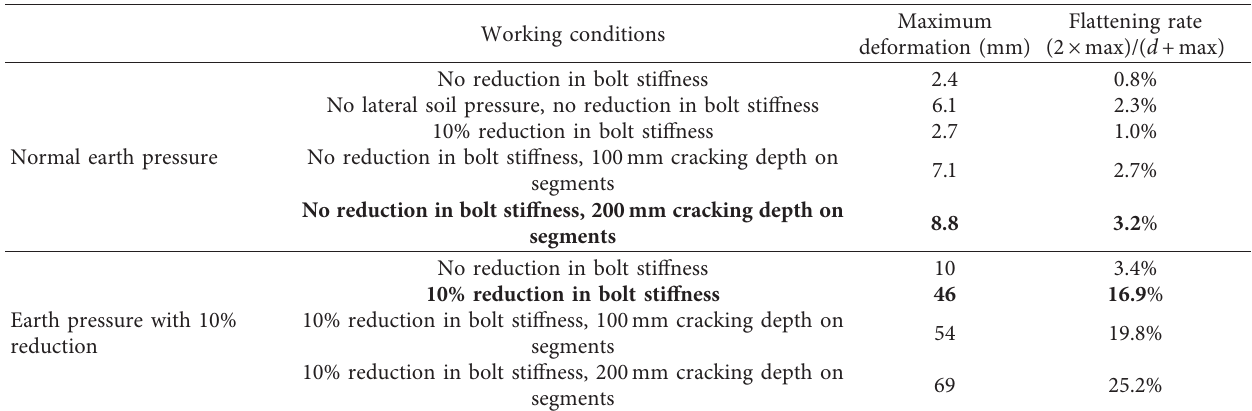
Figure 22: Staggered assembly of Table 3: Crack summation.